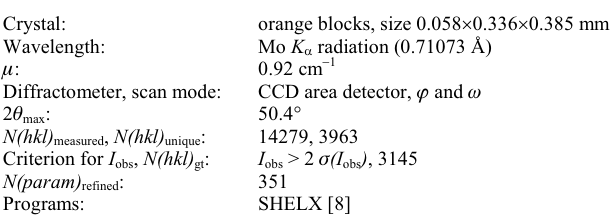
Table 1. Data collection and handling.